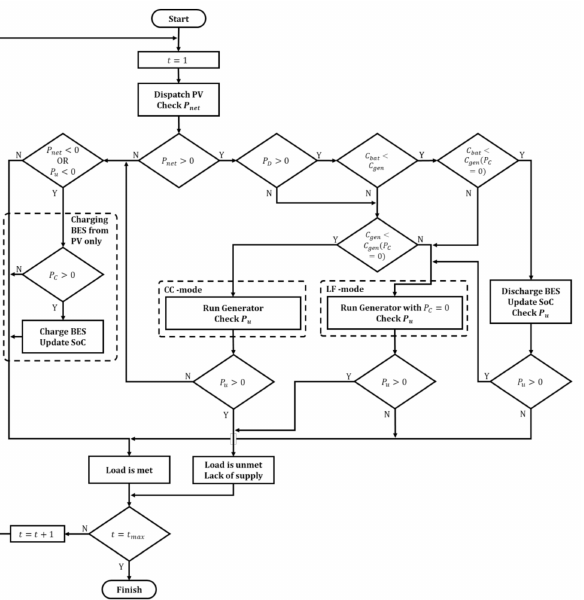
Figure 3. Combined Dispatch (CD) control strategy. The BES is charged using the excess power from the PV system or the generator during the low load period. The BES is discharged if the SOC is at maximum or if it has been discharged in the previous timestep as in CC control strategy, or if the BES can supplement the unmet power of PV system as if in LF control